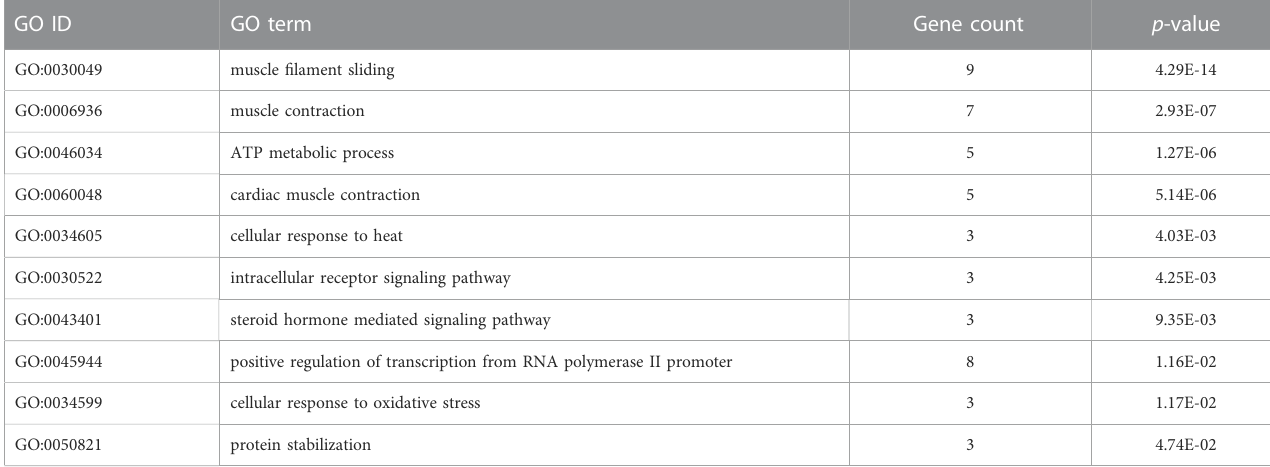
TABLE 2 Biological process GO terms of differentially expressed transcripts between the vehicle vs. mifepristone groups. GO